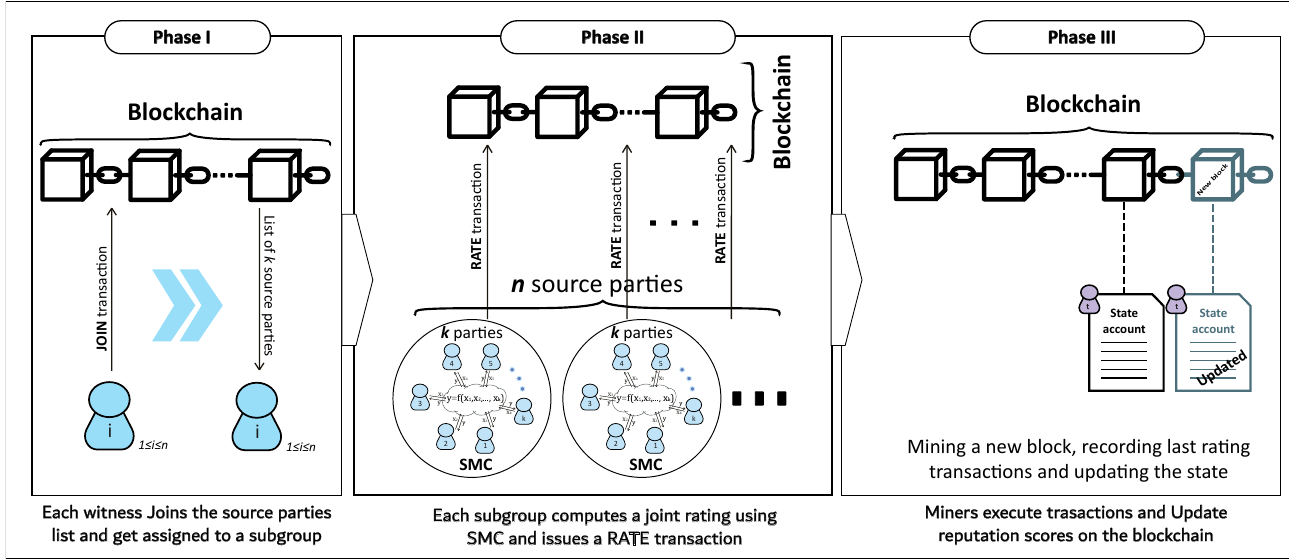
Figure 3. System